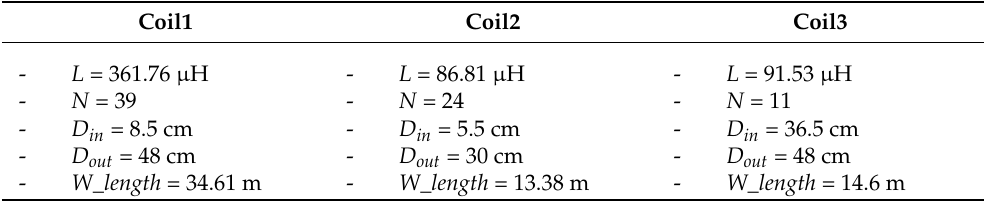
Table 3. Summary of the calculated parameters for each